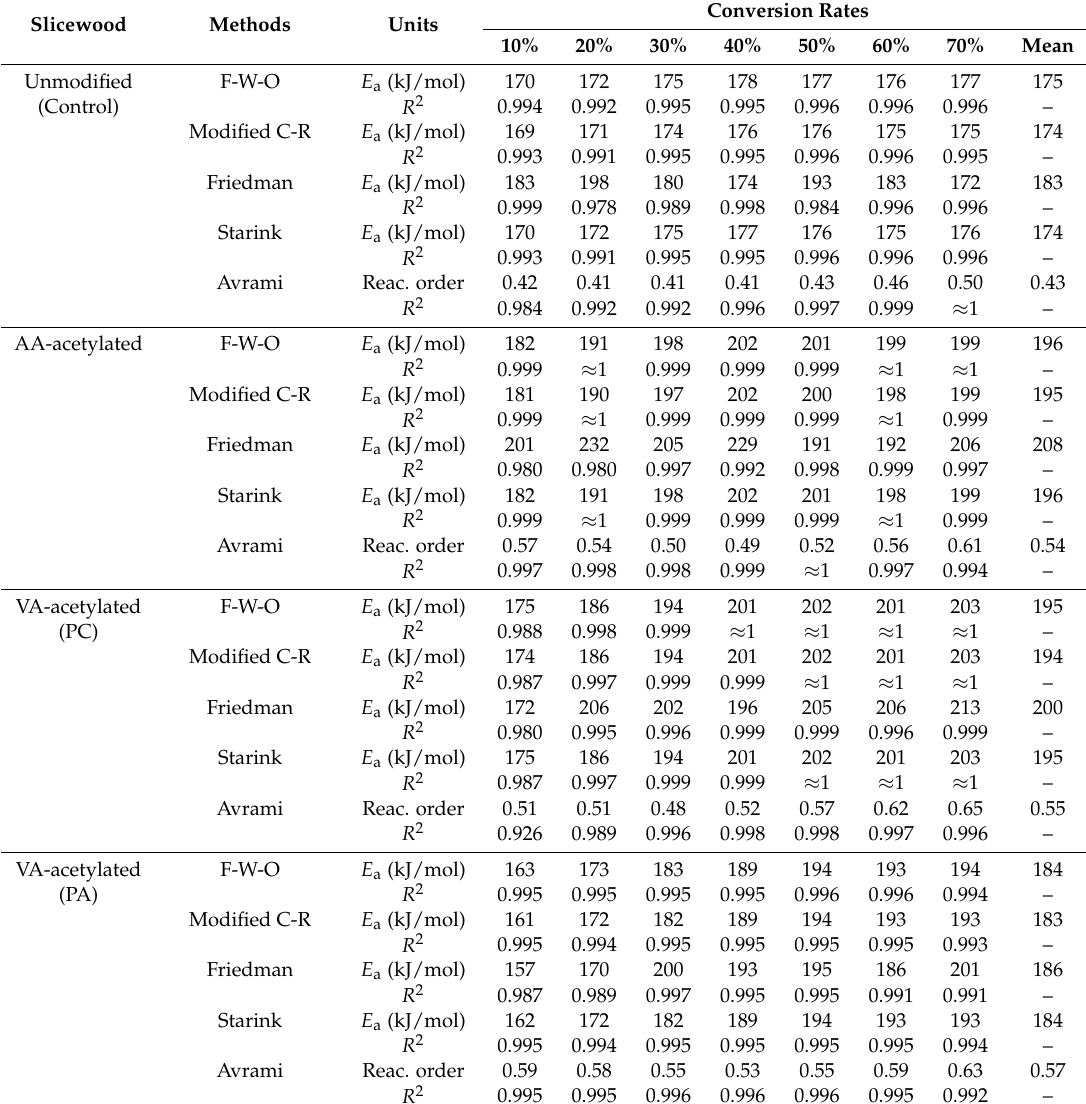
Table 2. Apparent activation energy and reaction order of unmodified slicewood, acetic anhydride (AA)-acetylated slicewood (WPG 18%), and vinyl acetate (VA)-acetylated slicewood (cWPG 18%) with potassium carbonate (PC) and potassium acetate (PA) calculated by the methods of Flynn-Wall-Ozawa (F-W-O), modified Coats-Redfern (C-R), Friedman, Starink, and Avrami. Slicewood